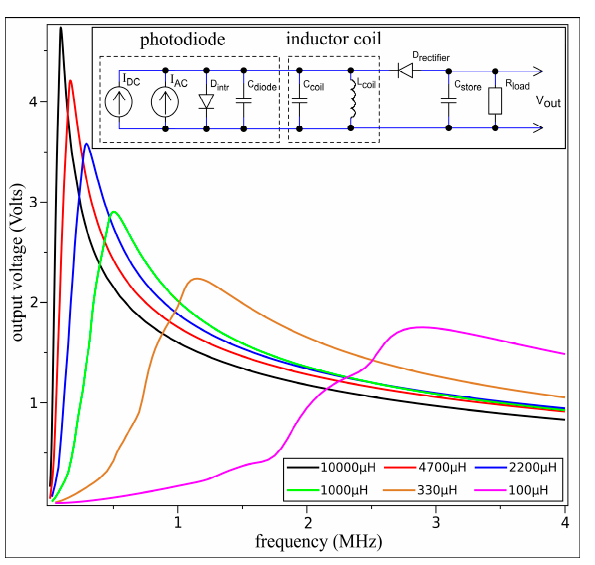
Figure 3. Frequency response of PFVVS found using SPICE. The inset shows the circuit used in the simulation. 133